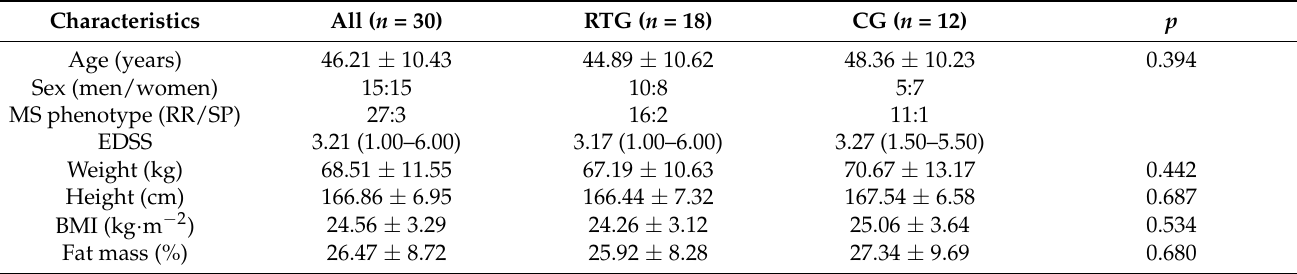
Table 1. Participant characteristics.